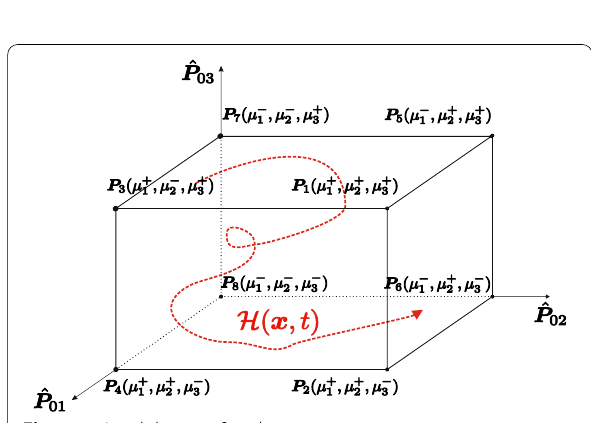
Figure 1 Load domain L and vertices P